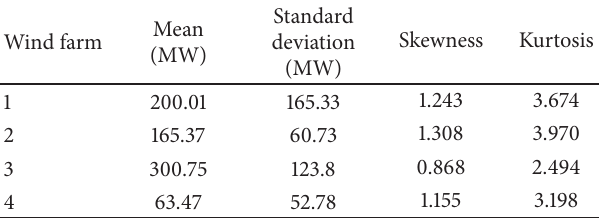
Table 3: Wind power input data of practical system.